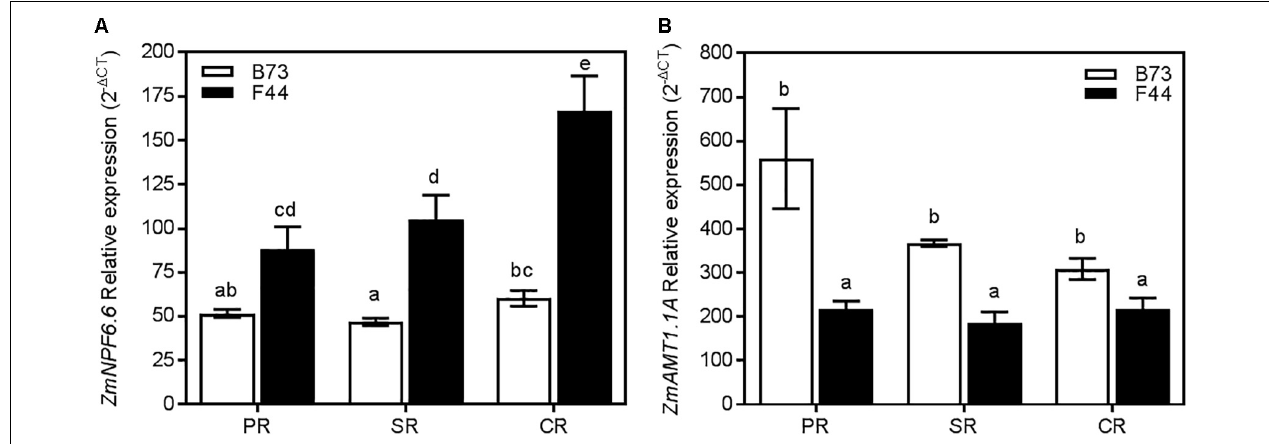
FIGURE 7 | Expression of ZmNPF6.6 (A) and ZmAMT1.1A (B) in B73 (white), and F44 (black) in the PR, seminal SR, and CR root tissues. Values are means ( ± SE) from 4 to 5 individual plants. Different letters indicate significant differences among means at P < 0.05